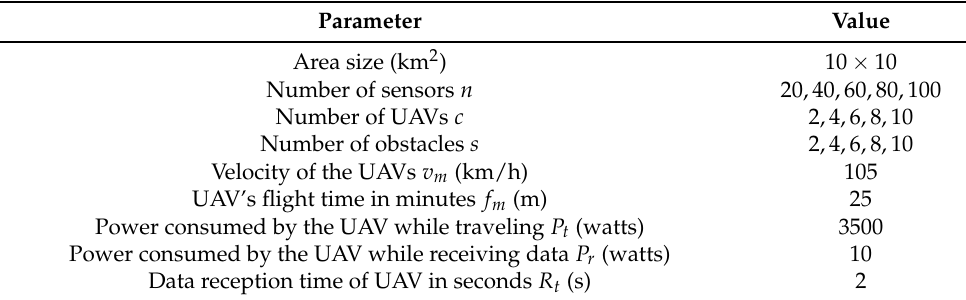
Table 2. Experimental parameters (underlined values are default